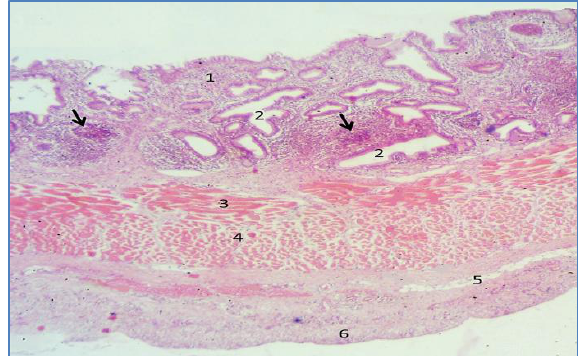
Figure, 8: longitudinal section of proctodeum wall (hen turkey) shows: tunica mucosa (1), epithelial glands (2) inner longitudinal striated muscle fibers (3), outer circular striated muscle fibers (4) hypodermis adipose tissue (5) and dermis (6) lymphatic nodules (arrows) (H and E) satin. 40x.